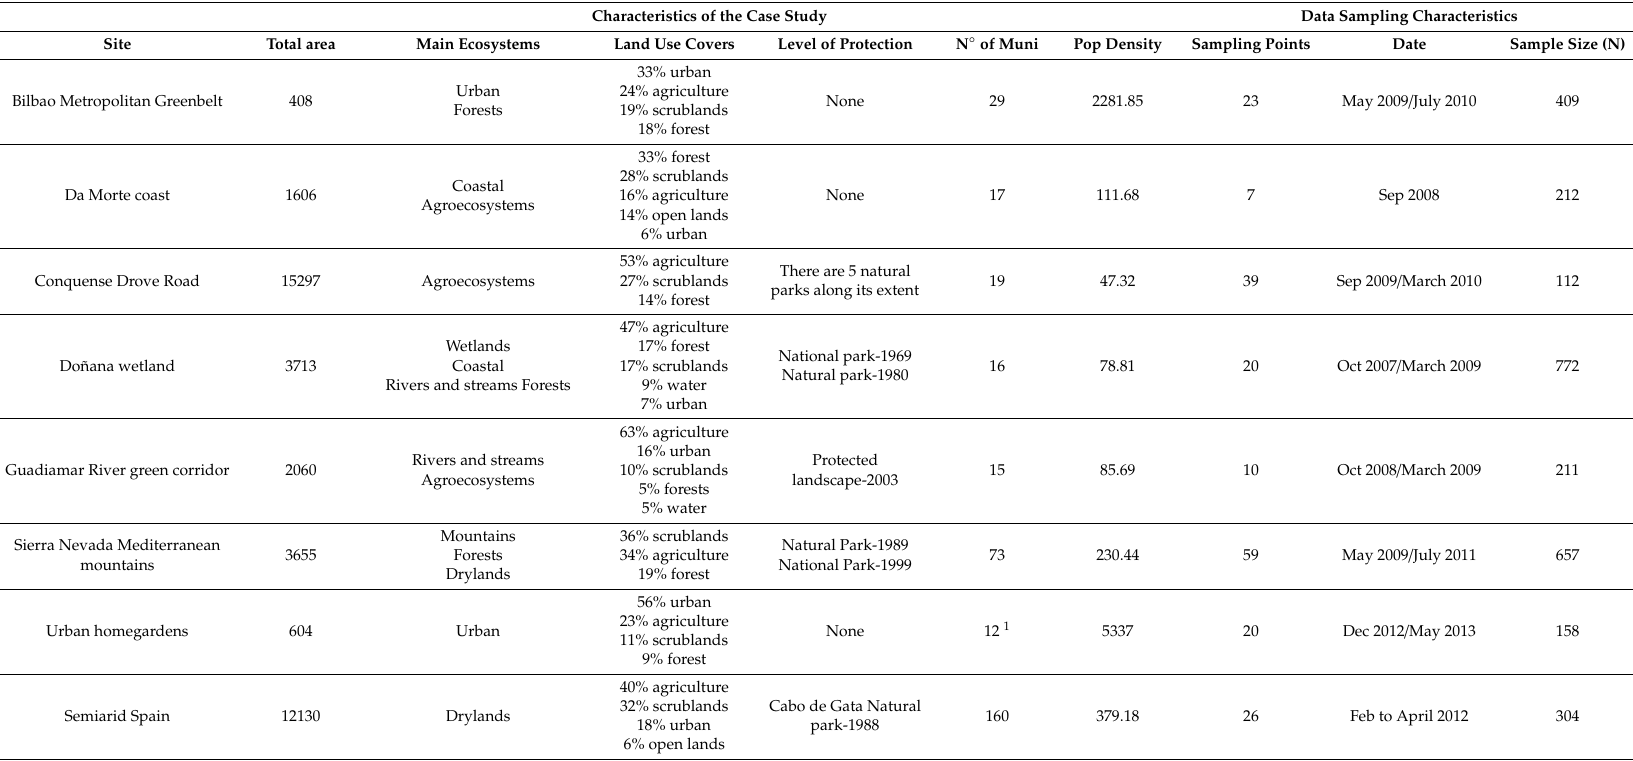
Table 1. Main characteristics of sites and data sampling characteristics in each case study. The total area is expressed in km 2 . Population density (pop density) is expressed in inhabitants / km. N ◦ of Muni: N ◦ of